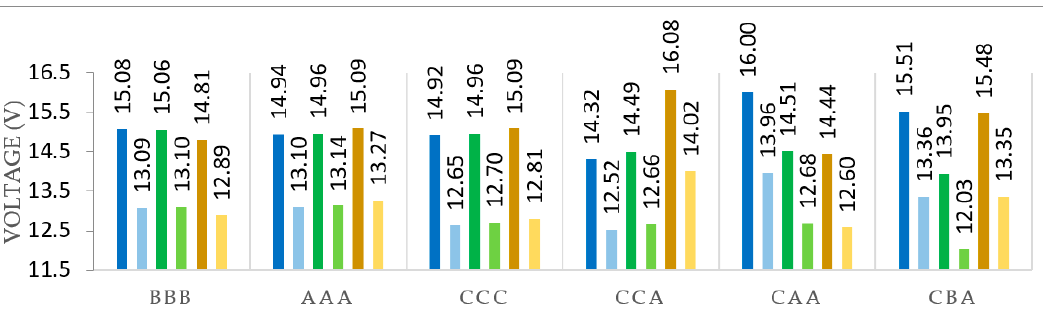
Figure 10. Voltage balance in CSCs depending on association at operating point N° 1 in ISOP config.